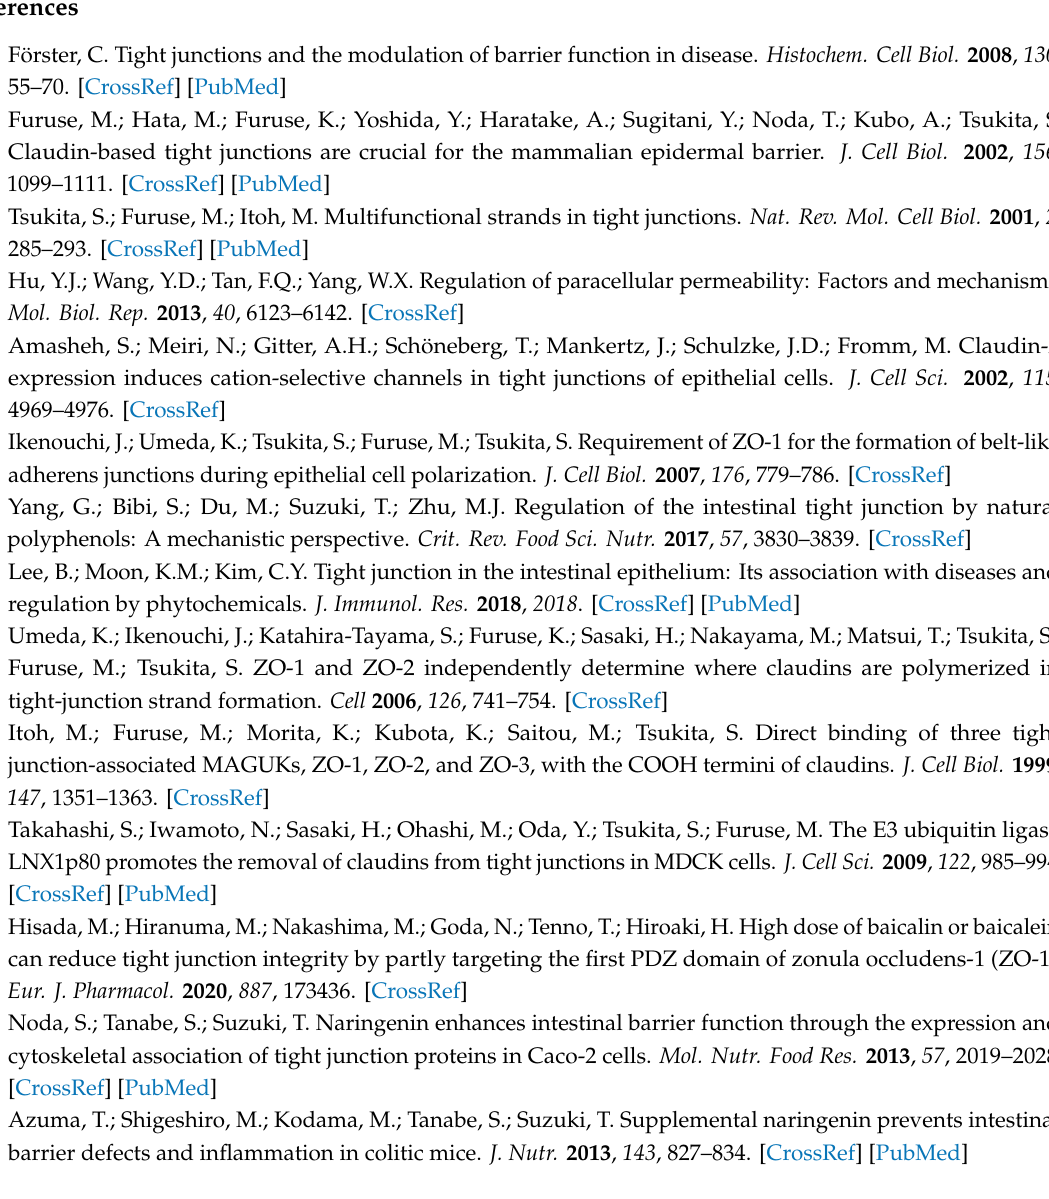
Figure S1. E ff ects of quercetin (QUE) on cell morphology in MDCK II cells, Figure S2. E ff ects of flavonoids on cell viability in MDCK II cells, Figure S3: E ff ects of flavonoids on the morphology and TJ integrity of MDCK II cells, Figure S4. E ff ects of QUE on CLD-2 expression in MDCK II cells. Figure S5: E ff ects of flavonoids on CLD-2 expression in MDCK II cells, Figure S6: Direct interaction between LNX-1(PDZ2) and the flavonoids, Figure S7: Direct interaction between ZO-1(PDZ1) and the flavonoids, Figure S8: E ff ects of NAR on CLD-1, -3, -4 and -7 expression in MDCK II cells, Figure S9: E ff ects of compounds on CLD-2 expression in MDCK II cells, Table S1: E ff ects of flavonoids on NMR and amount of CLD-2. Result of research is the above, Table S2: E ff ects of quercetin (QUE) on some CLDs. Result of research is the above. table and charts, M.N.; data analysis, M.N., T.T., A.K., and Y.I.; resources, T.T. and N.G.; writing and original